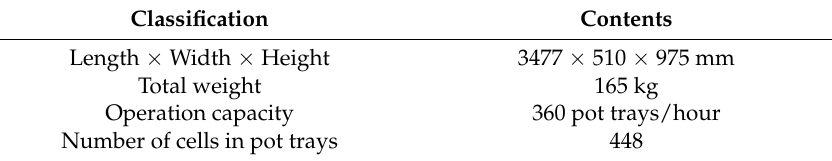
Figure 1. Picture of the roller-type onion pot-seeding machine. Table 1. Specifications of the roller-type onion pot-seeding machine.